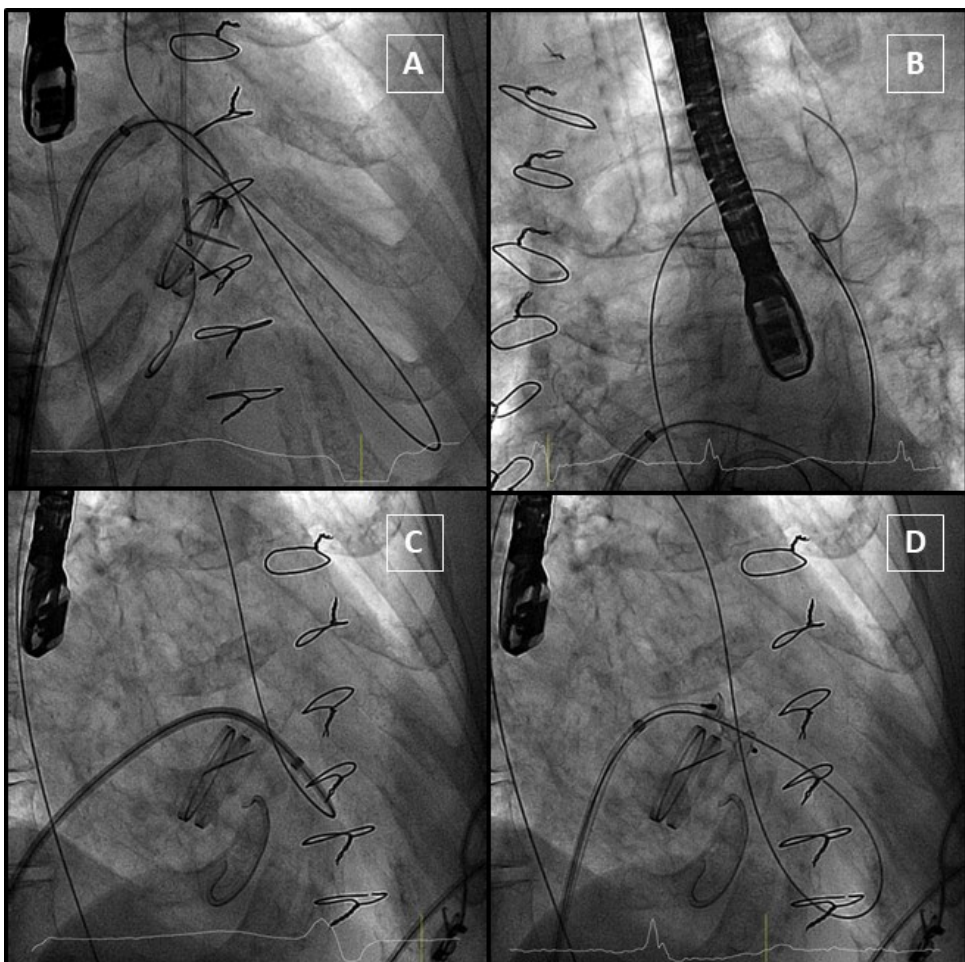
Figure 8. Anterograde approach. ( A ): Hydrophilic guidewire passes through the PVL and gets into aorta. ( B ): Guidewire is snared from an arterial access to complete the arteriovenous loop. ( C ): The delivery sheath crosses the PVL. ( D ): The device is delivered, and it does not interfere with the mechanical prosthesis.